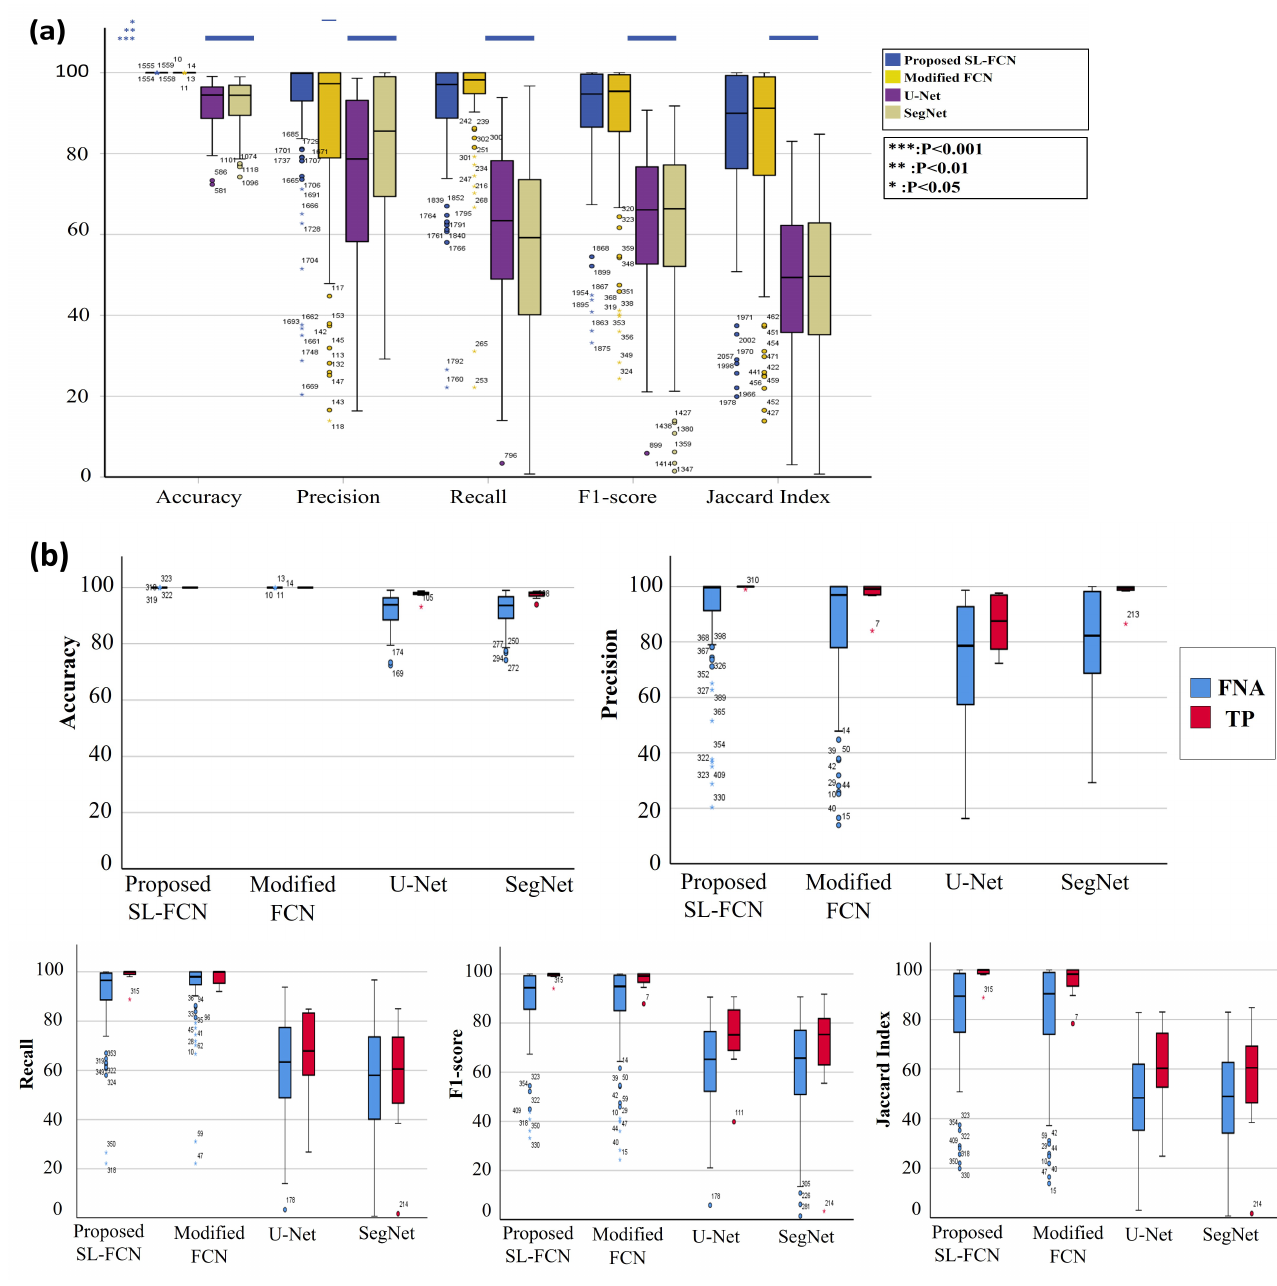
Figure 7. The box plots of quantitative evaluation results of the thyroid cancer dataset,